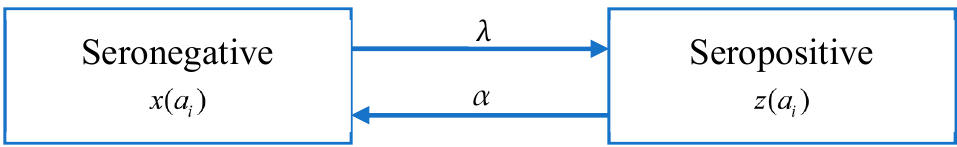
Figure 3. Model B: The catalytic model that assumes constant FOI and antibody decay.